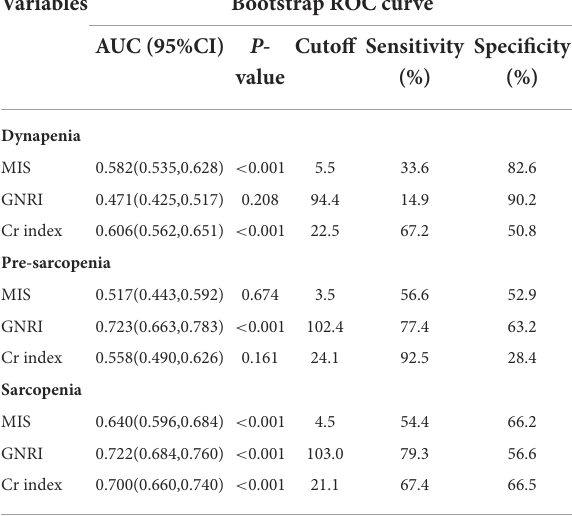
TABLE 1 Baseline characteristics of study participants according to the presence of sarcopenia. Characteristics